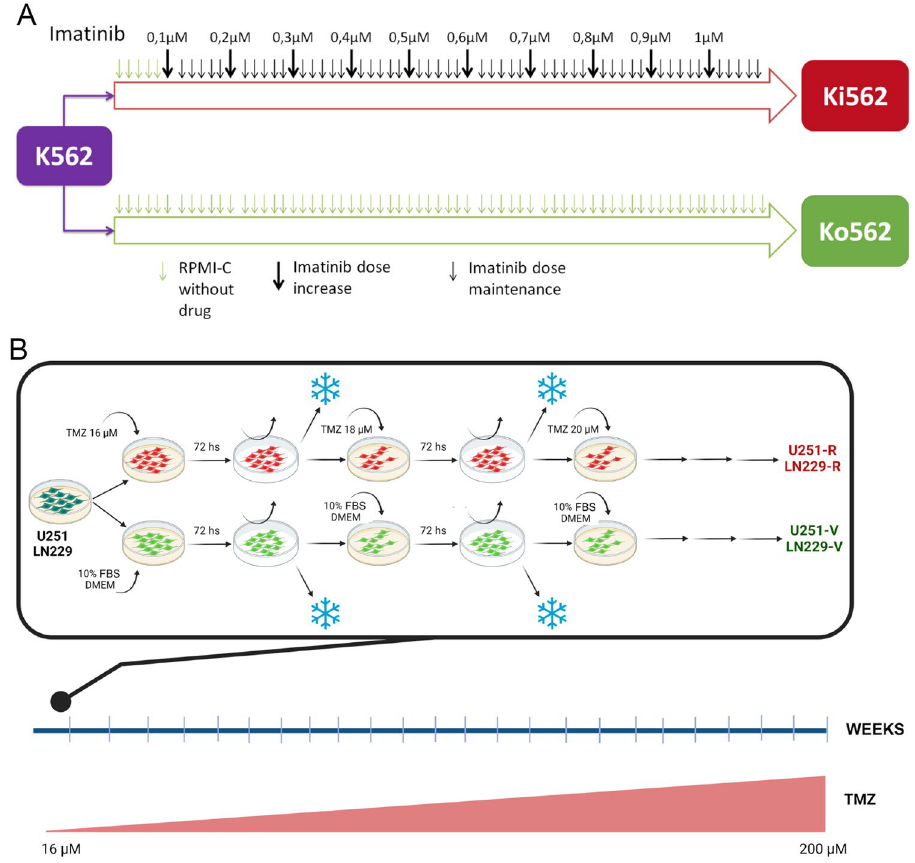
Figure 1. Establishment of resistant cell lines. ( A ) Ki562 cells were obtained by culturing K562 cells in the presence of increasing doses of imatinib. In parallel, K562 cells were grown without drug selection pressure, in order to accumulate the same level of culture aging. The latter was named Ko562. ( B ) U251 and LN229 were cultured with increasing doses of TMZ, obtaining U251-R and LN229-R cells, respectively. Both cell lines